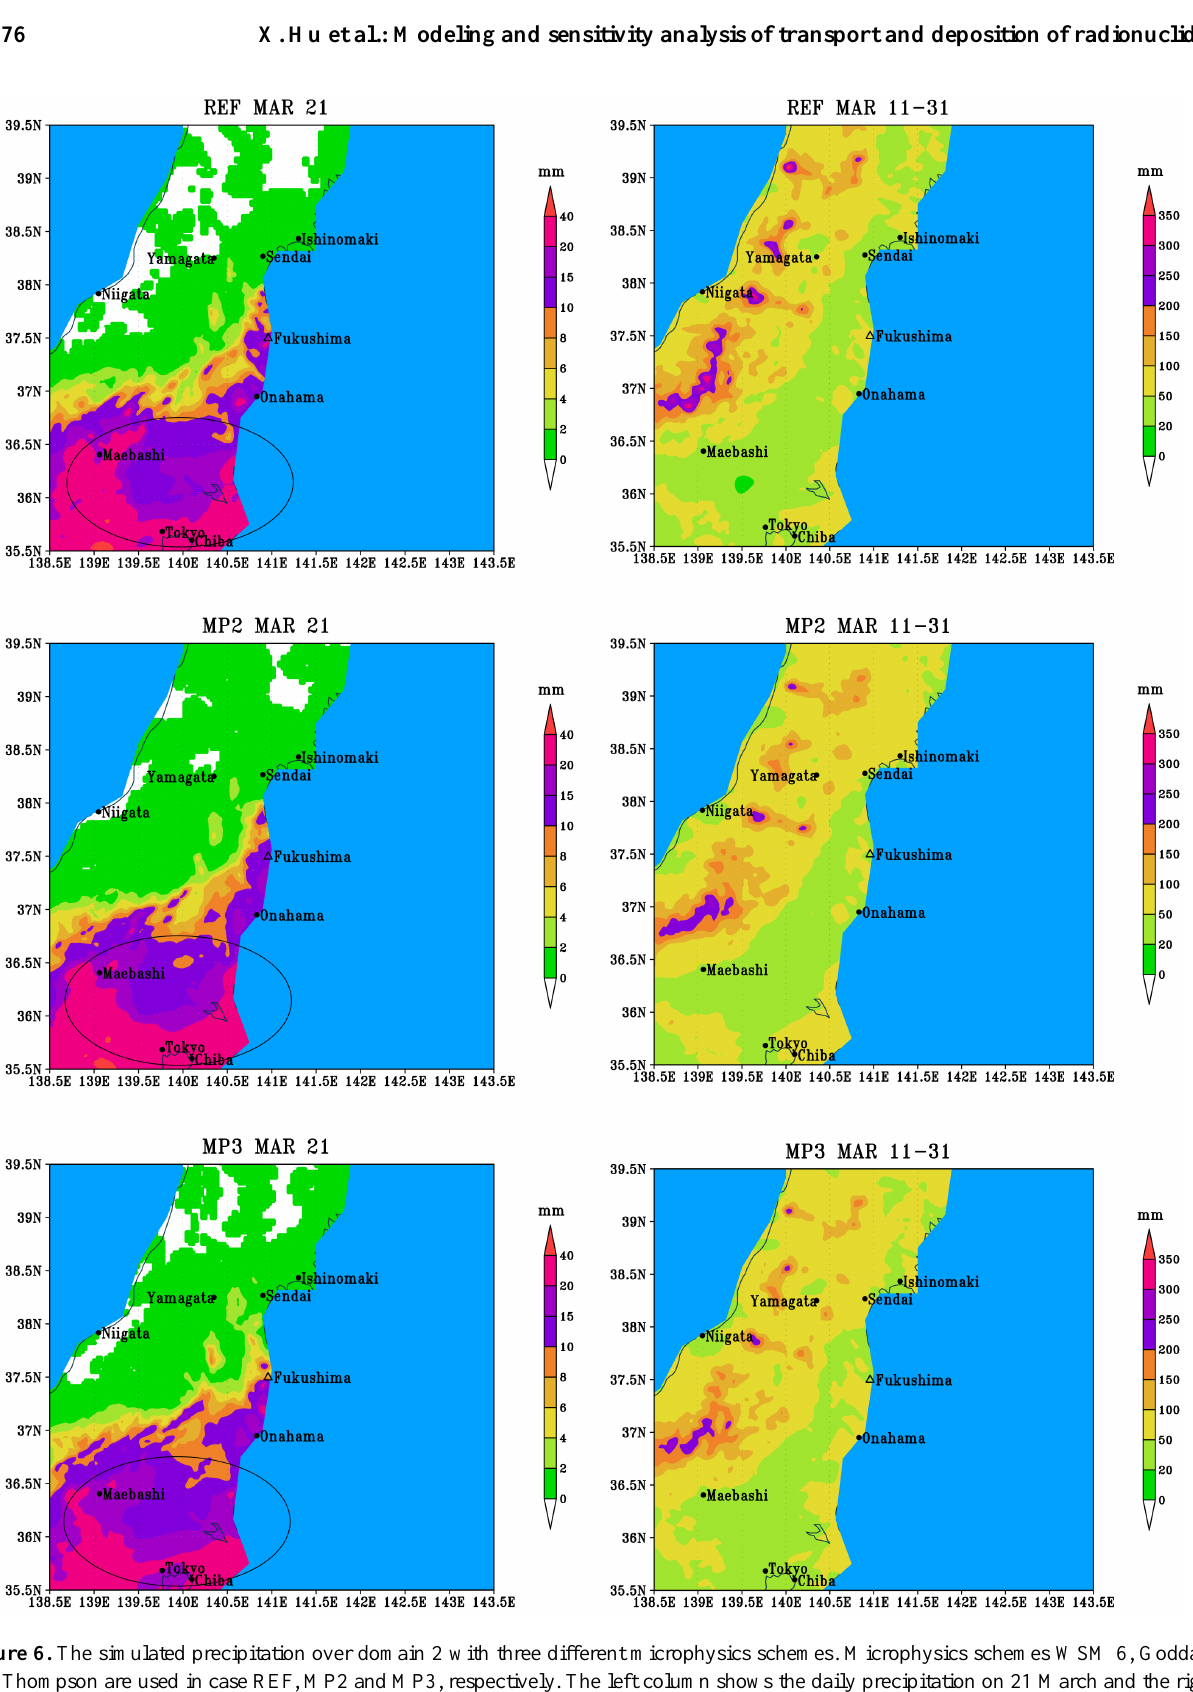
Figure 6. The simulated precipitation over domain 2 with three different microphysics schemes. Microphysics schemes WSM 6, Goddard and Thompson are used in case REF, MP2 and MP3, respectively. The left column shows the daily precipitation on 21 March and the right column shows the accumulated precipitation from 11 to 31